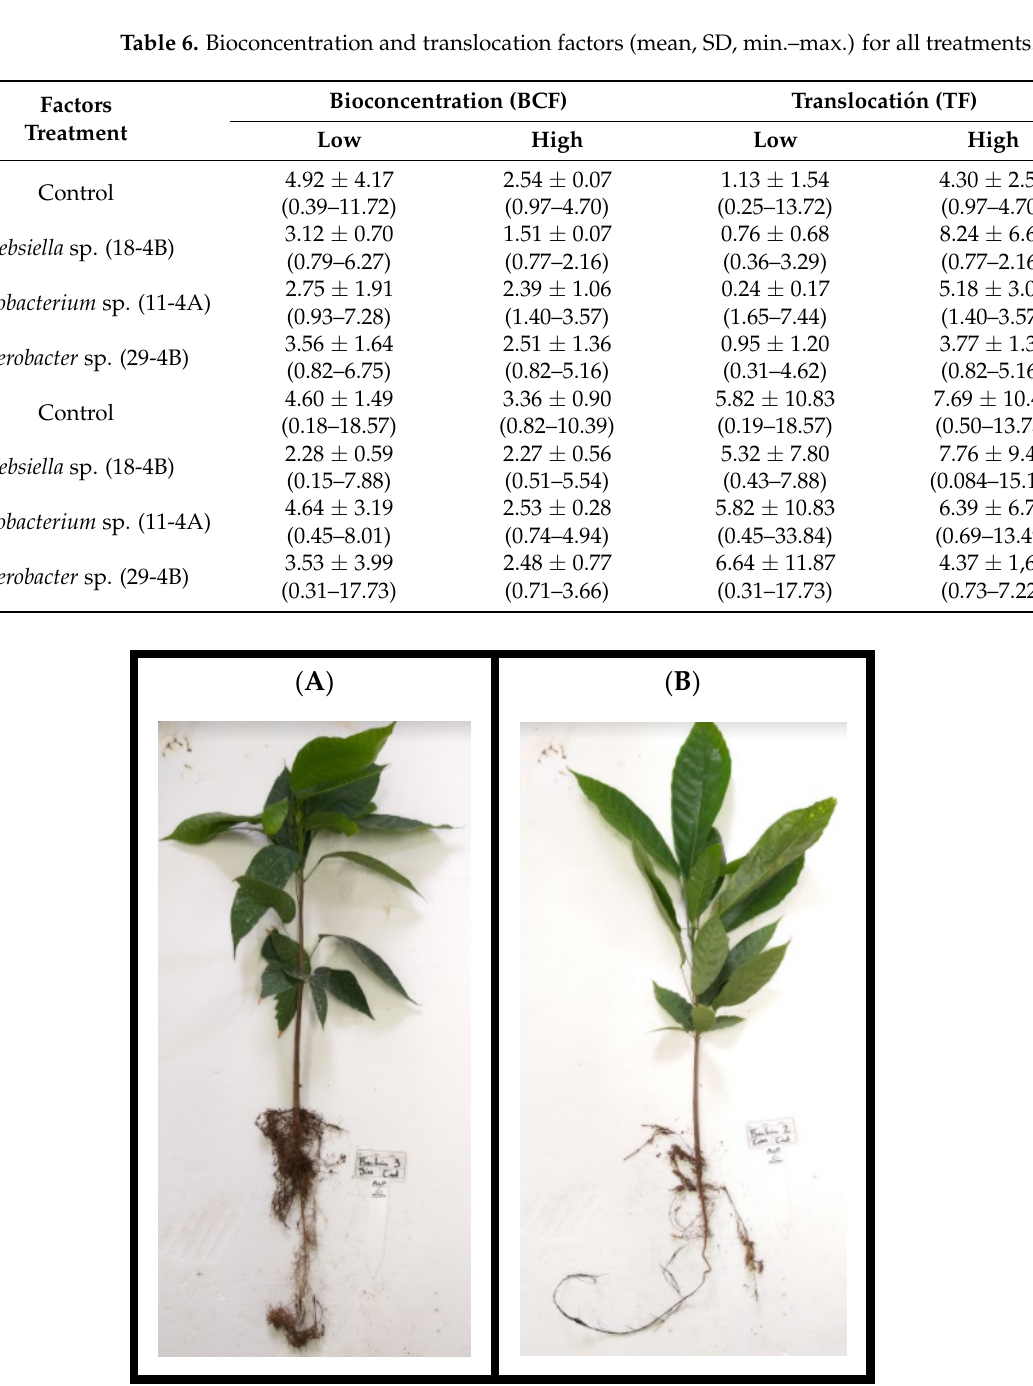
Figure 3. ( A ). Cacao plant without Cd: high biomass aerial, stem large, thick, and various branches; principal root large and straight and abundant secondary roots. ( B ) Cacao plant with Cd concentration: low biomass aerial, stem short, thin; branches cover the top of the stem; principal root was large, thin, curved, and fragile; a few secondary roots. Table 6. Bioconcentration and translocation factors (mean, SD, min.–max.) for all treatments.